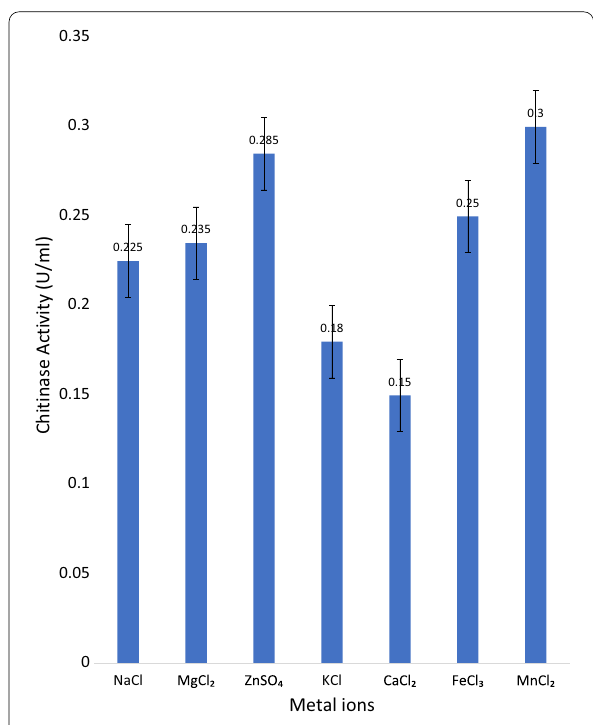
Fig. 6 Chitinase producing activity of Streptomyces albus at different metal